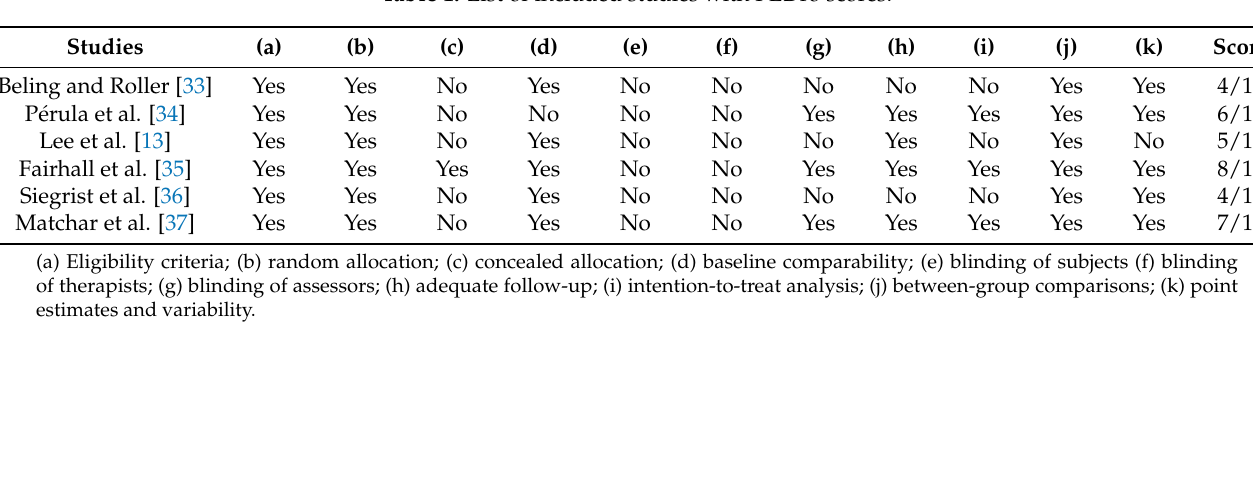
Figure 1. PRISMA flowchart showing the inclusion and exclusion in this systematic review. Table 1. List of included studies with PEDro